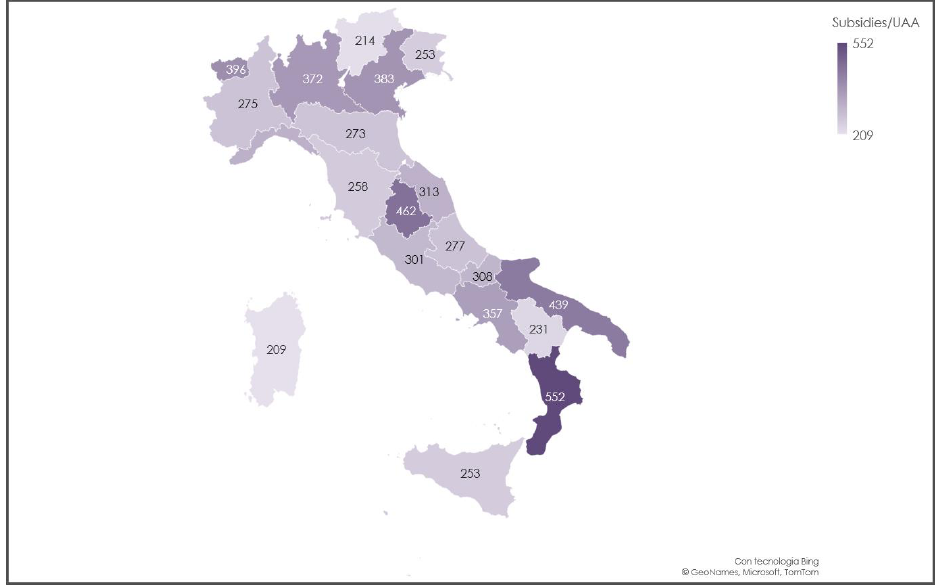
Figure 12. Subsidies per hectare in the Italian regions.